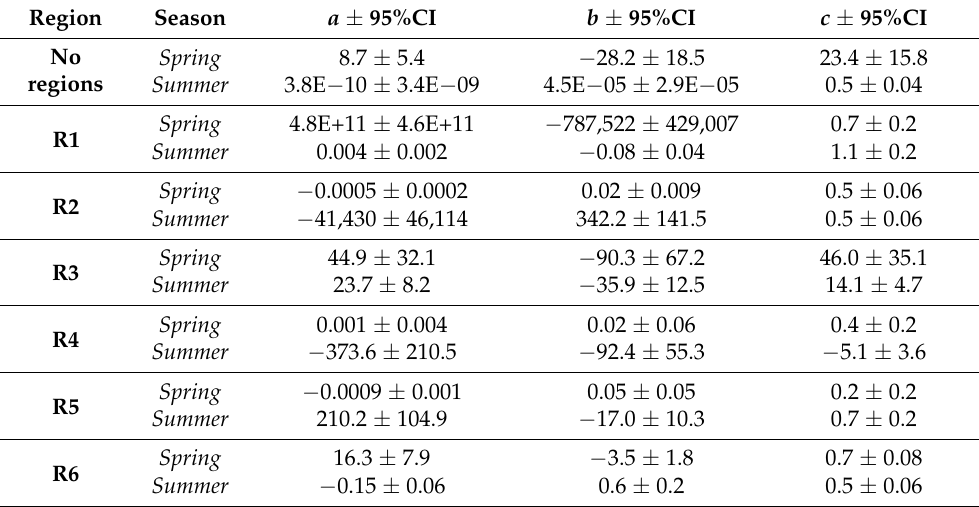
Table 11. The coefficients of the quadratic polynomial regression ( a , b and c , used in Equation (1)) to derive TP with the 95% confidence interval values